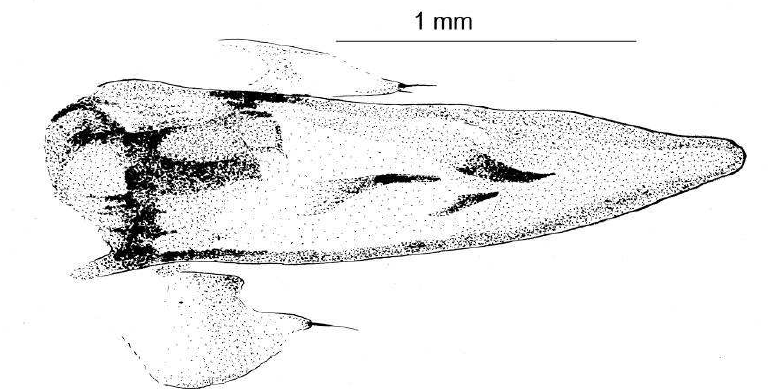
F IGURE 4 . Deltomerus (Deltomerus) veldkampi sp. nov., median lobe of aedeagus, dorsal aspect. Scale: 1mm.